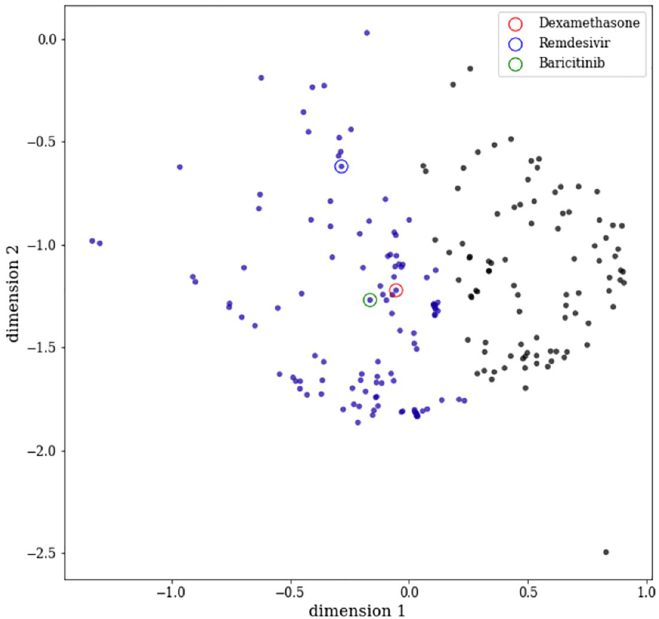
Fig 4. The output of t-SNE dimensionality reduction using a perplexity of 170 from 200 principal components. It is to be noted that the clump with purple colour code contains three reference drugs. The colours on each data point were obtained as a result of applying a simple K-means clustering assuming 2 clusters.